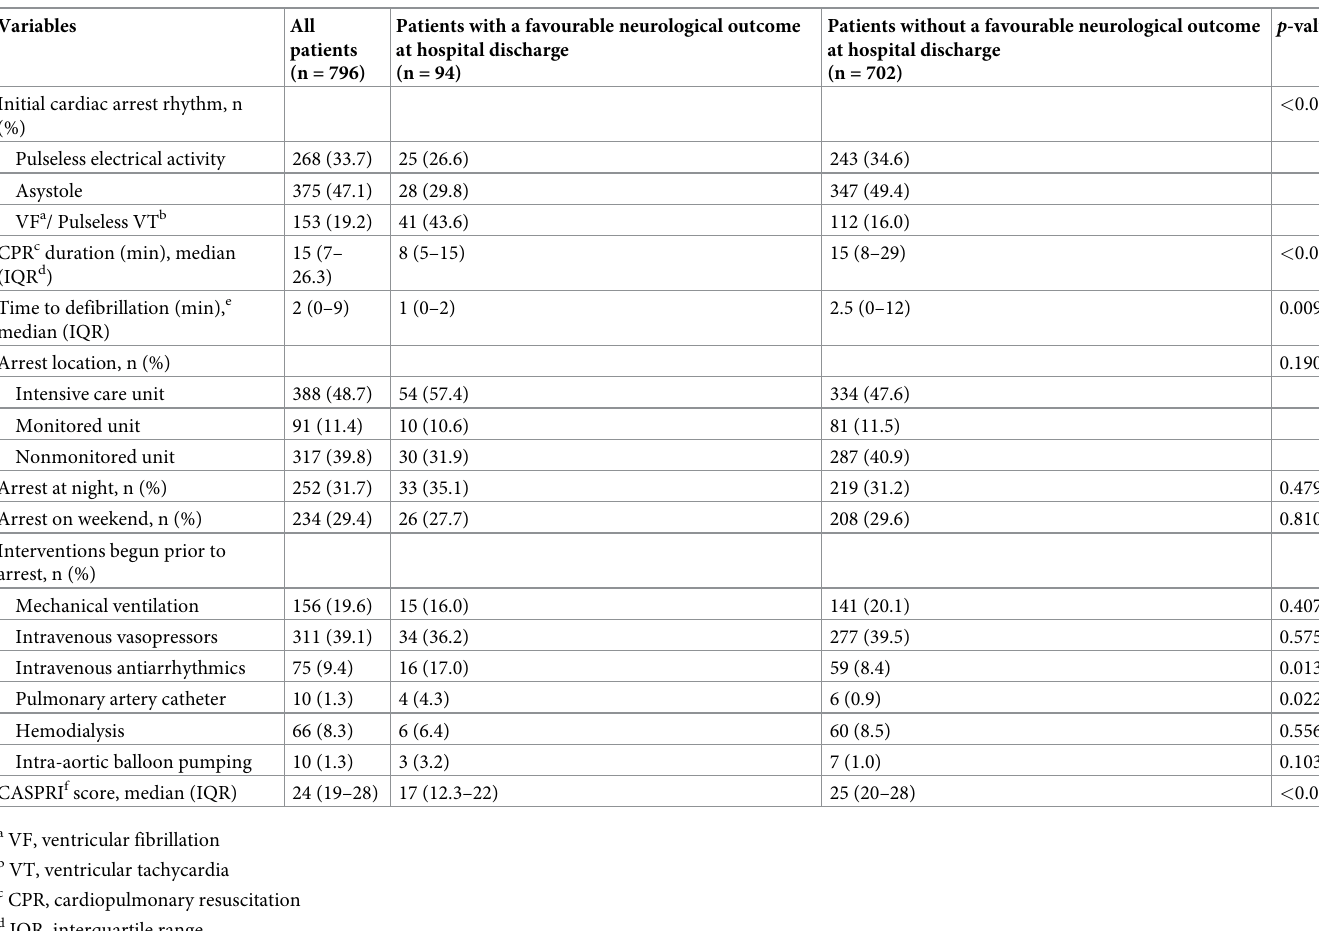
Table 2. Features and interventions of cardiac arrest events by neurological status at hospital